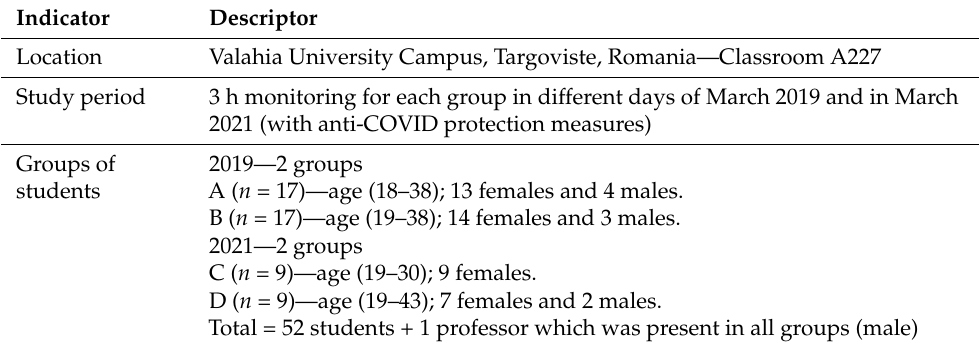
Table 1. Setup of the experiment to determine the PM load and thermal microclimate in a university classroom in the presence of various groups of students without masks (2019) and with disposable face masks